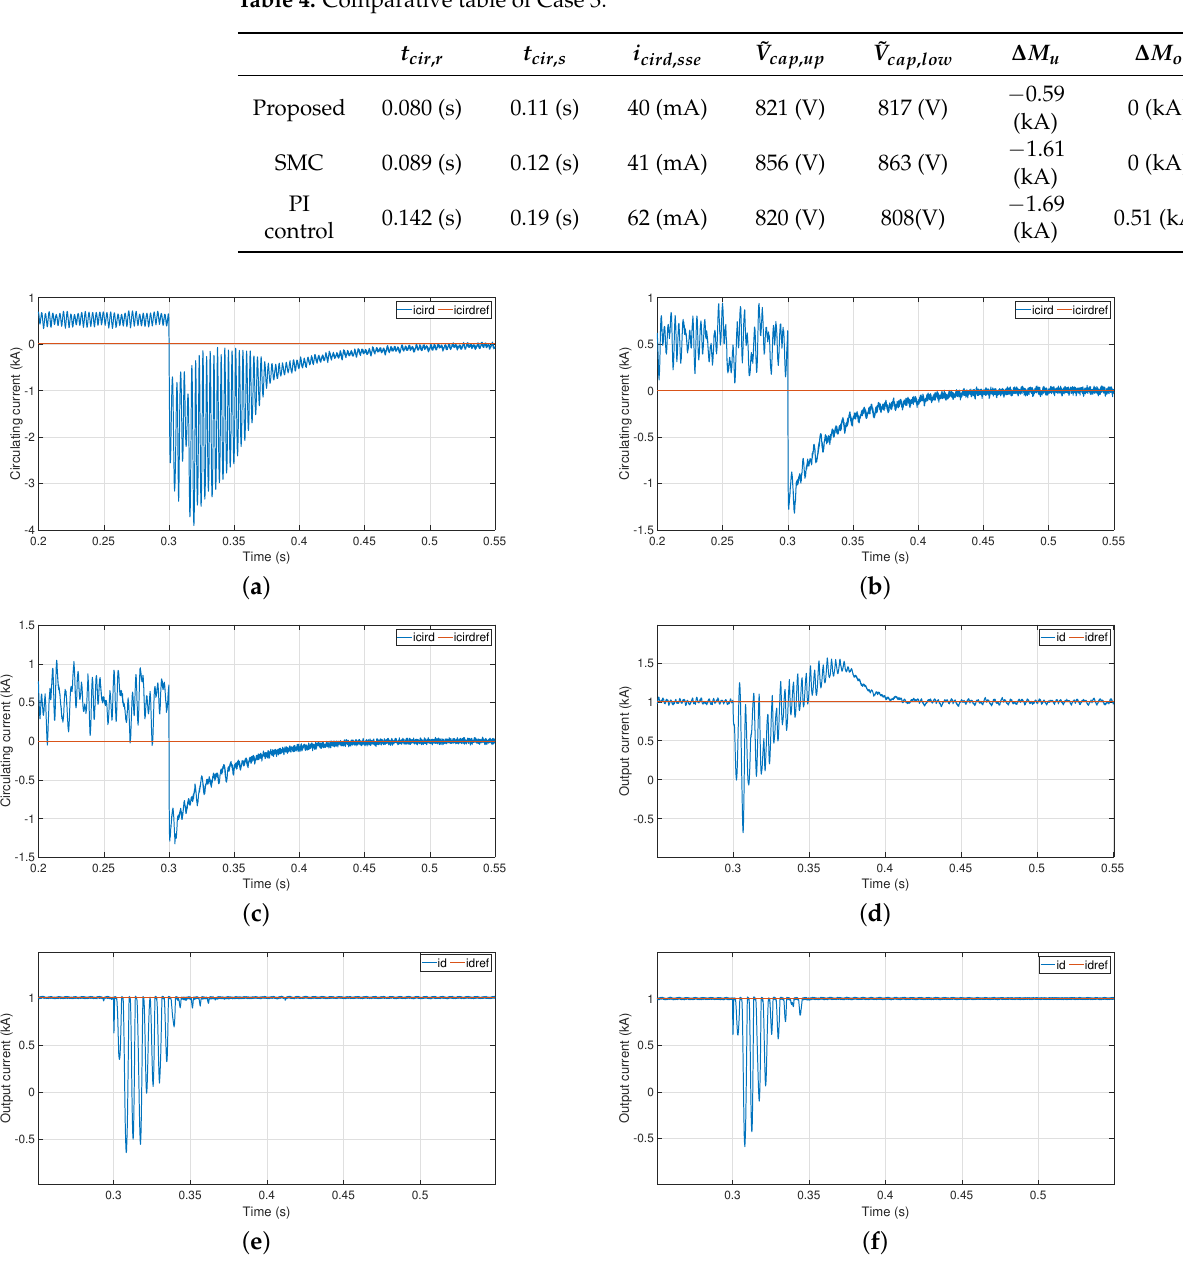
Table 4. Comparative table of Case 3.